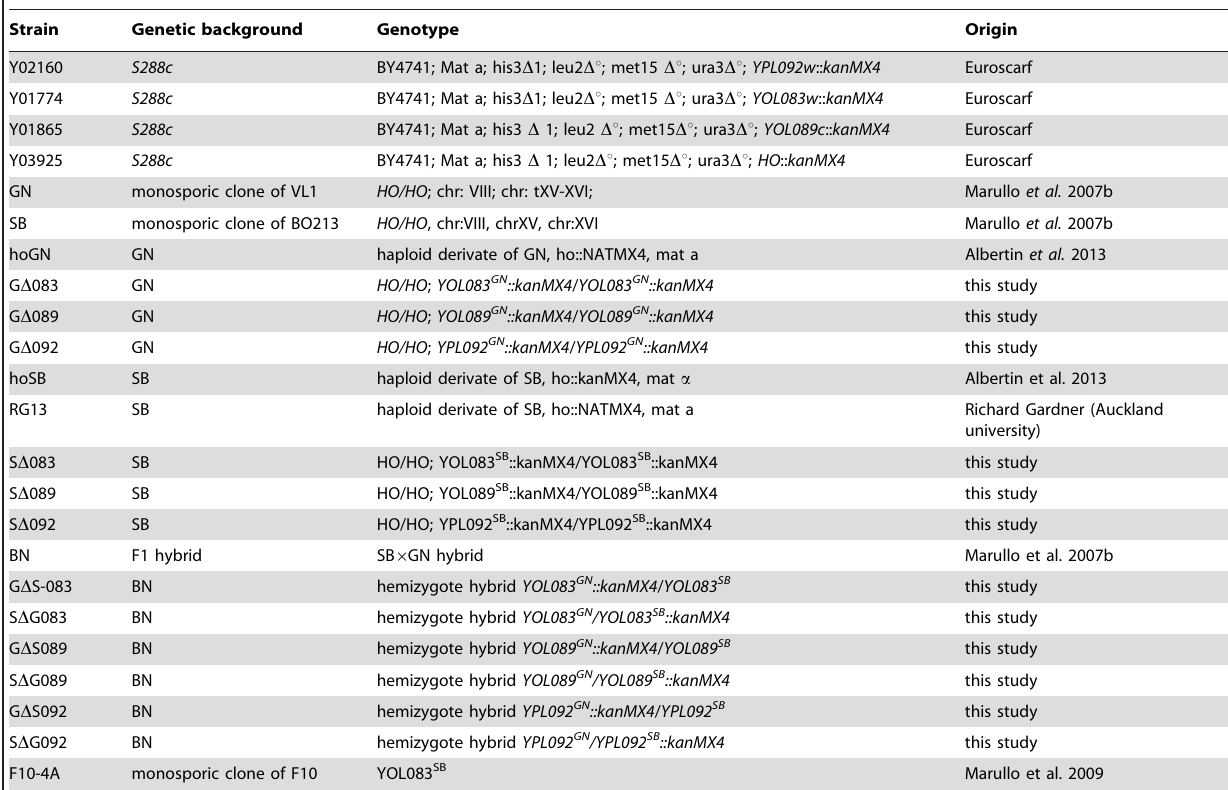
Table 1. Yeast strains used.